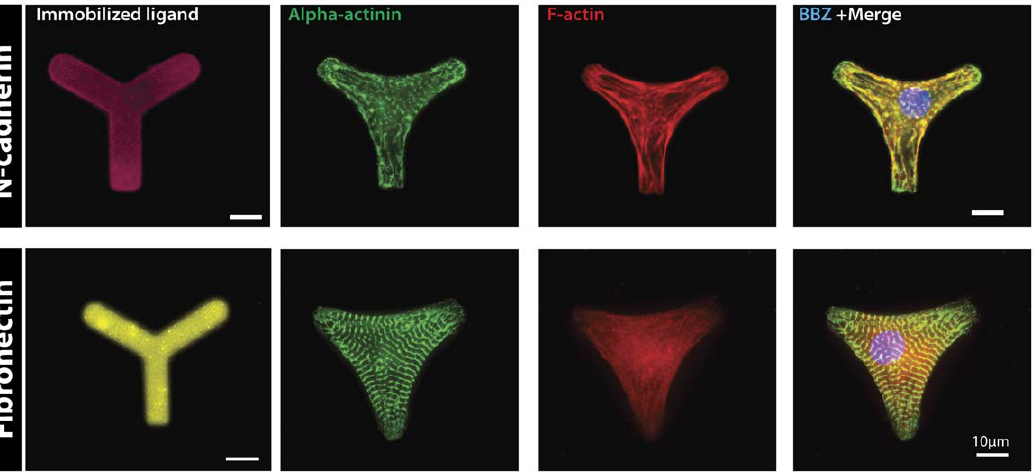
Figure 1. Myocytes plated on ‘Y’ patterns for 72 hours (Top row, left to right) N-cad stained micropattern, myocytes on N-cad coated patterns stained for a -actinin (green), F-actin (red), merged image of cardiac myocyte (nucleus stained with Bisbenzimide (BBZ), blue) show poor a -actinin and thin filament organization. (Bottom row, left to right) Fibronectin stained micropattern, myocytes stained for the same cytoskeletal markers show highly organized sarcomere registration governed by the anisotropy of the adhesion geometry. Scale bar indicate 10 m m.